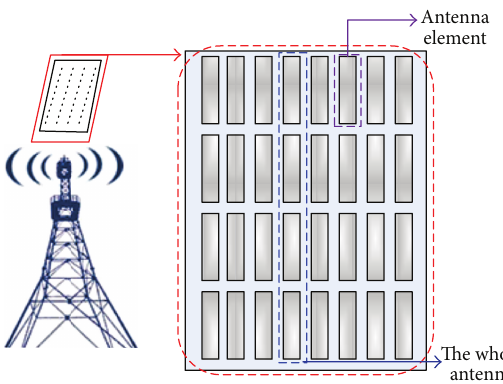
Figure 2: Structure of 8 × 4 rectangular 3D antenna